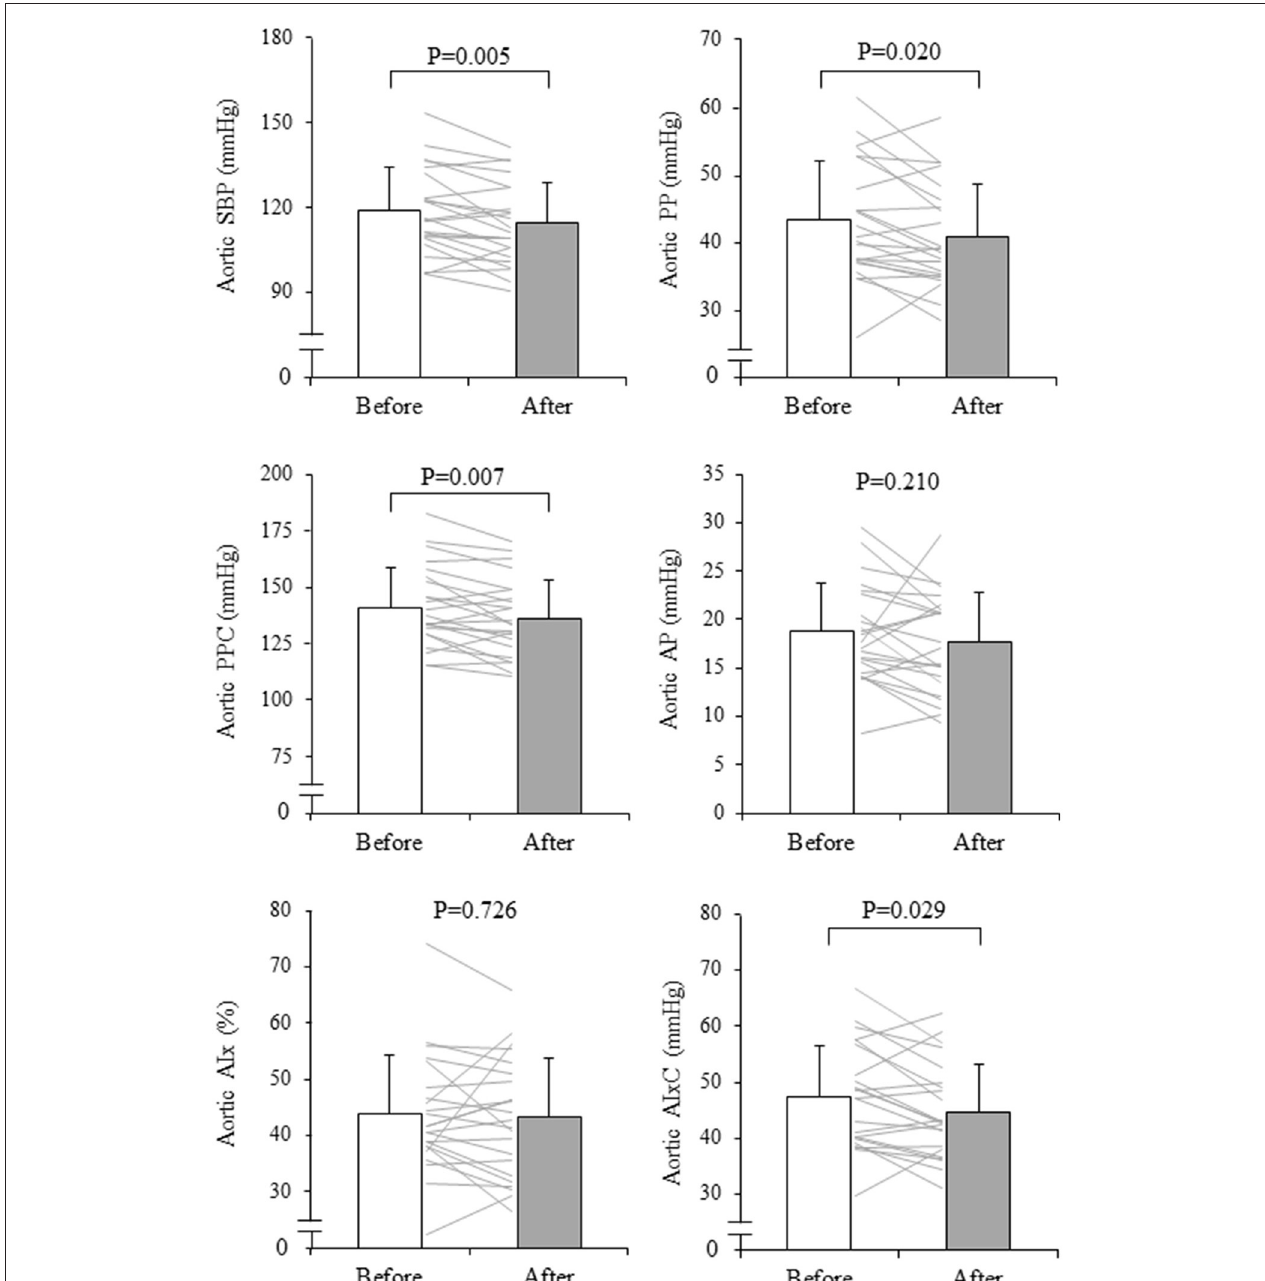
FIGURE 3 | Changes in aortic systolic blood pressure (SBP), pulse pressure (PP), reflection wave (AP, augmentation pressure and AIx, augmentation index), and companion index (PPC, companion of PP and AIxC, companion of AIx) with aquatic exercise training intervention. The thin line shows the change before and after the intervention for an individual and the bars show mean SD. P -values are the results of the paired t ±